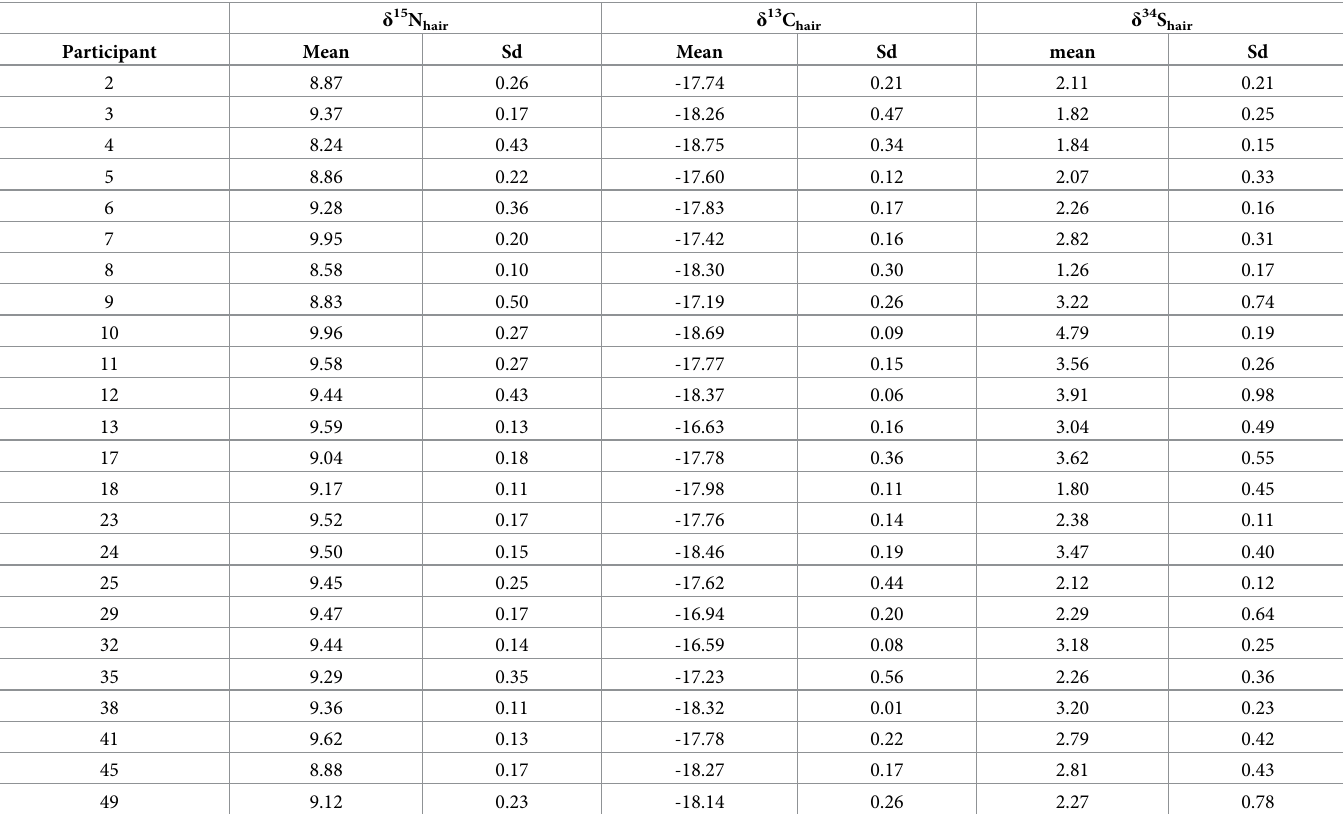
Table 7. Comparison of means and standard deviations of δ 15 N hair , δ 13 C hair and δ 34 S hair values for the 25 participants resampled every 6 months across a four-year period (S2 Data). Numbers highlighted in red correspond to isotopic profiles with a high variance and described in the discussion section. Analytical precision is 0.2‰ for δ 15 N hair and δ 13 C hair and 0.4‰ δ 34 S hair